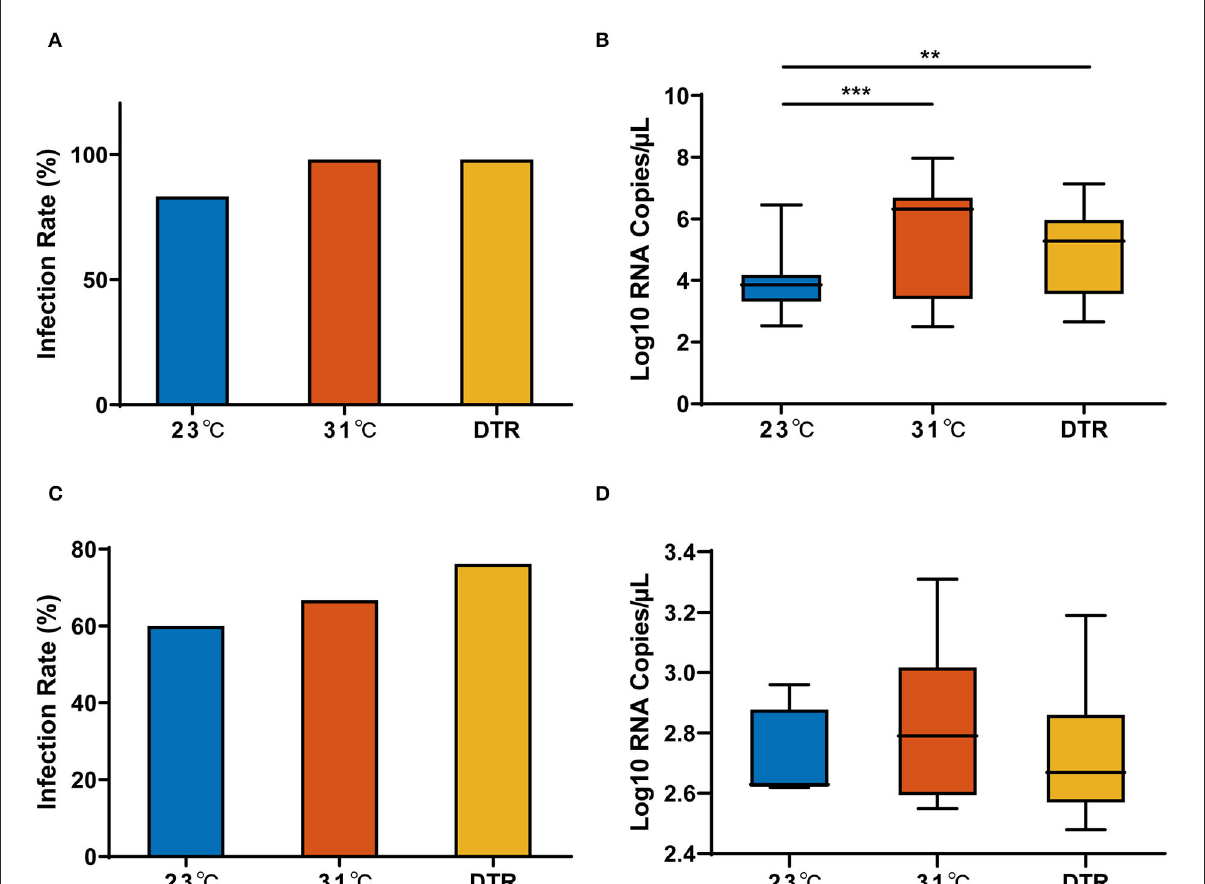
FIGURE4 Zika virus infection rate and load in parental and progeny mosquitoes at different temperatures. Zika virus infection rate (A) and RNA copy number (B) in the parental Ae. albopictus ; Zika virus infection rate (C) and RNA copy number (D) in the progeny Ae. albopictus . IR of parental mosquitoes, n = 50; IR of progeny mosquitoes, n = 6–21. Box plots show the median and the 25–75th percentiles, and the whiskers denote the maximum and minimum values. The chi-square test was used to analyze the IR and Kruskal–Wallis test with Dunn’s multiple comparisons test was used to analyze the Zika virus viral load of the mosquitoes. ** P < 0.01, *** P <